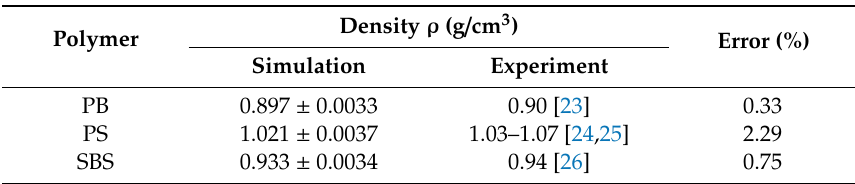
Table 2. Densities of PB, PS, and SBS system from simulations and experiments at T = 298.15 K, P = 1